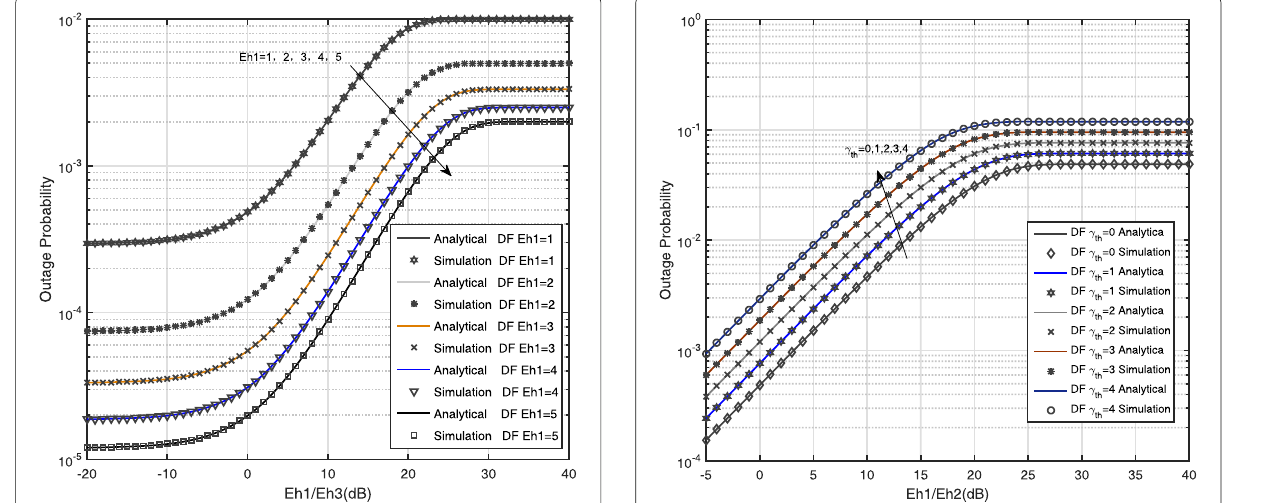
E h 1 = { 1, 2, 3, 4, 5 } . We can get that the outage proba- bility for a lower E h 1 outperforms the one for a higher E h 1 .